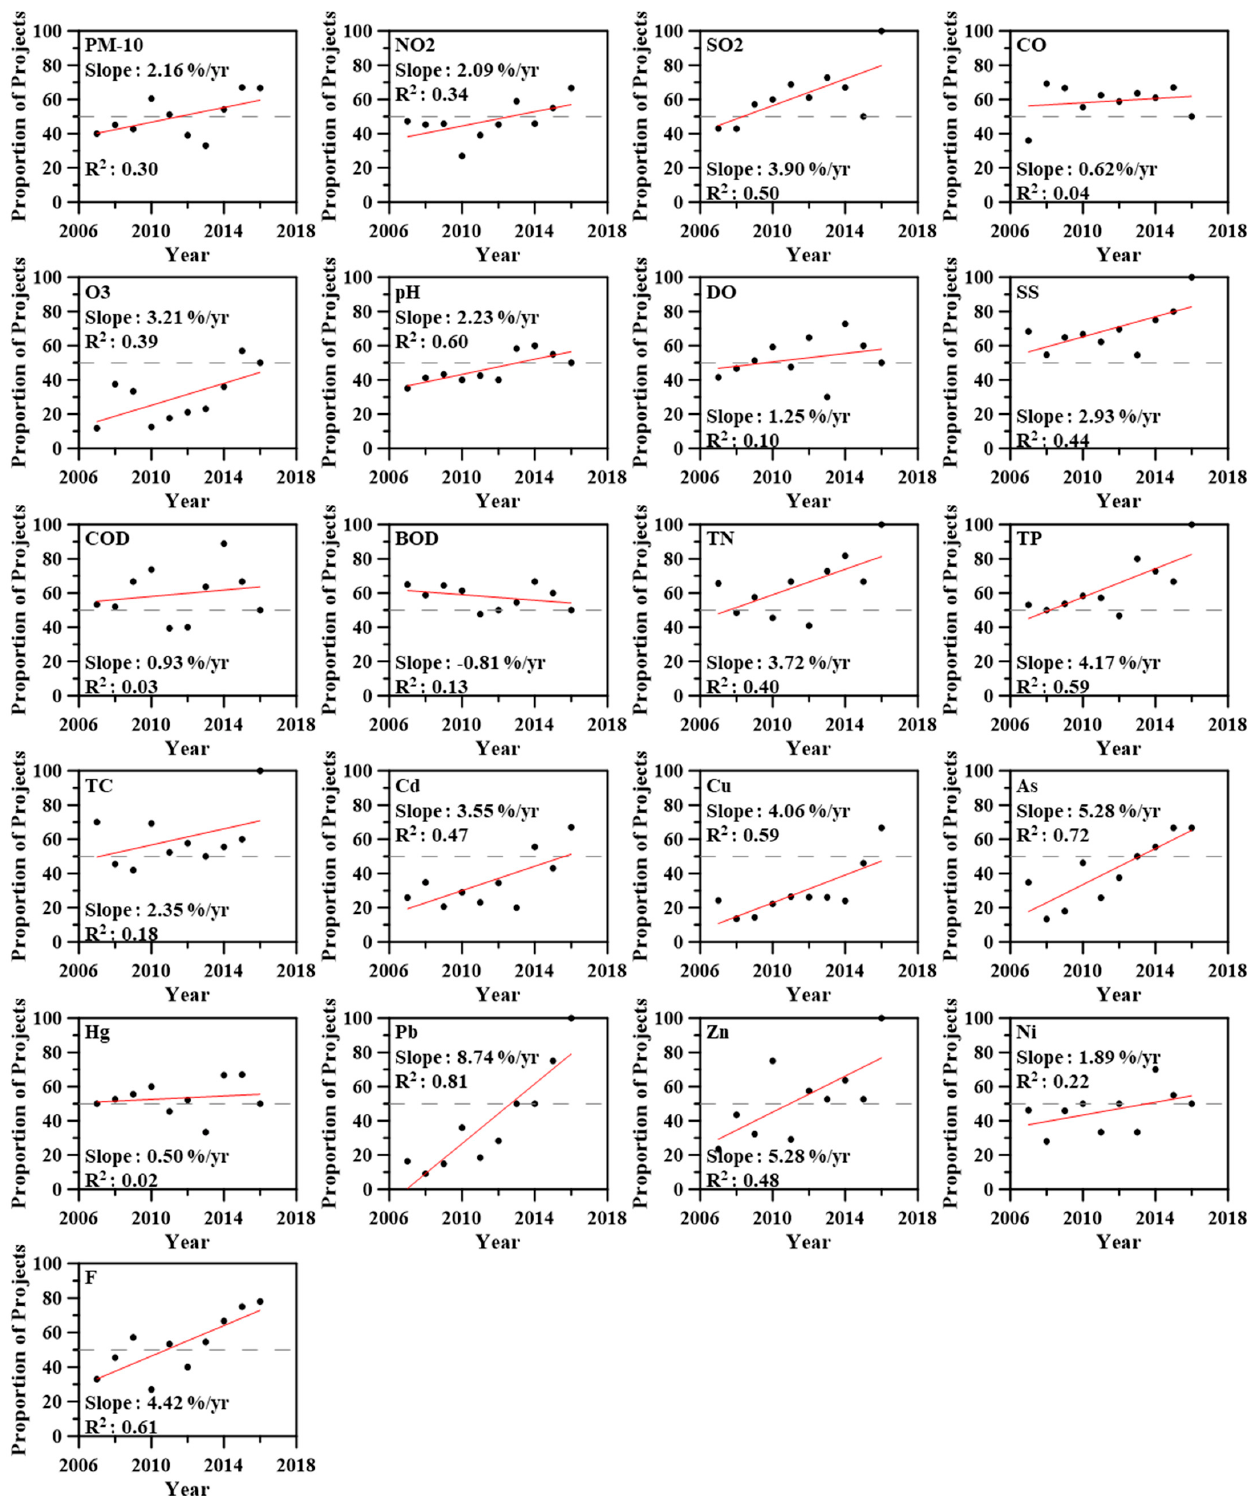
Figure 4. Proportion of environmentally friendly projects trends according to each indicator. The y-axis means proportion of environmentally friendly development projects.